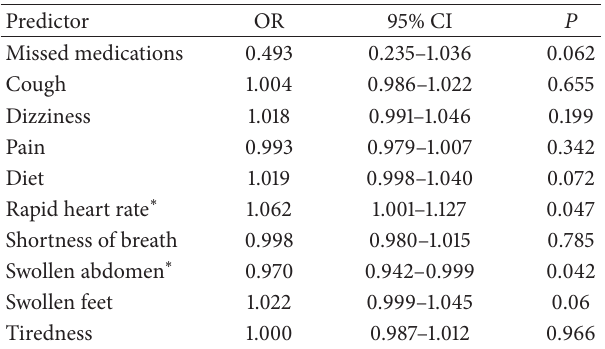
Table 3: Multivariable heart failure symptom predictors of 30-day hospital readmission ( 𝑛 = 100